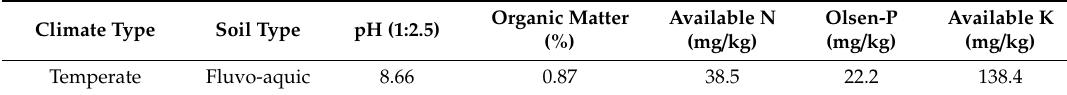
Table 2. Climate characters and soil basic properties (0–20 cm depth) of field sites in Hebei province, China.